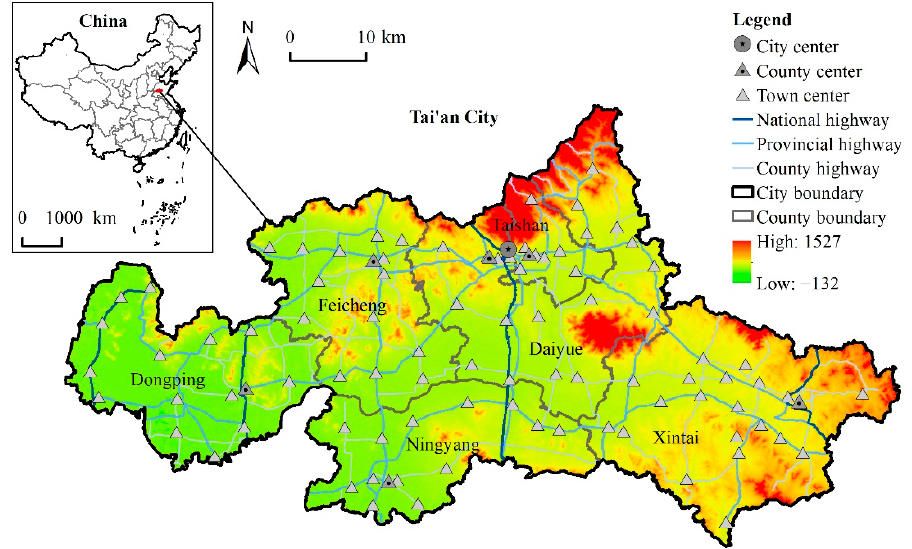
Figure 1. The study area.